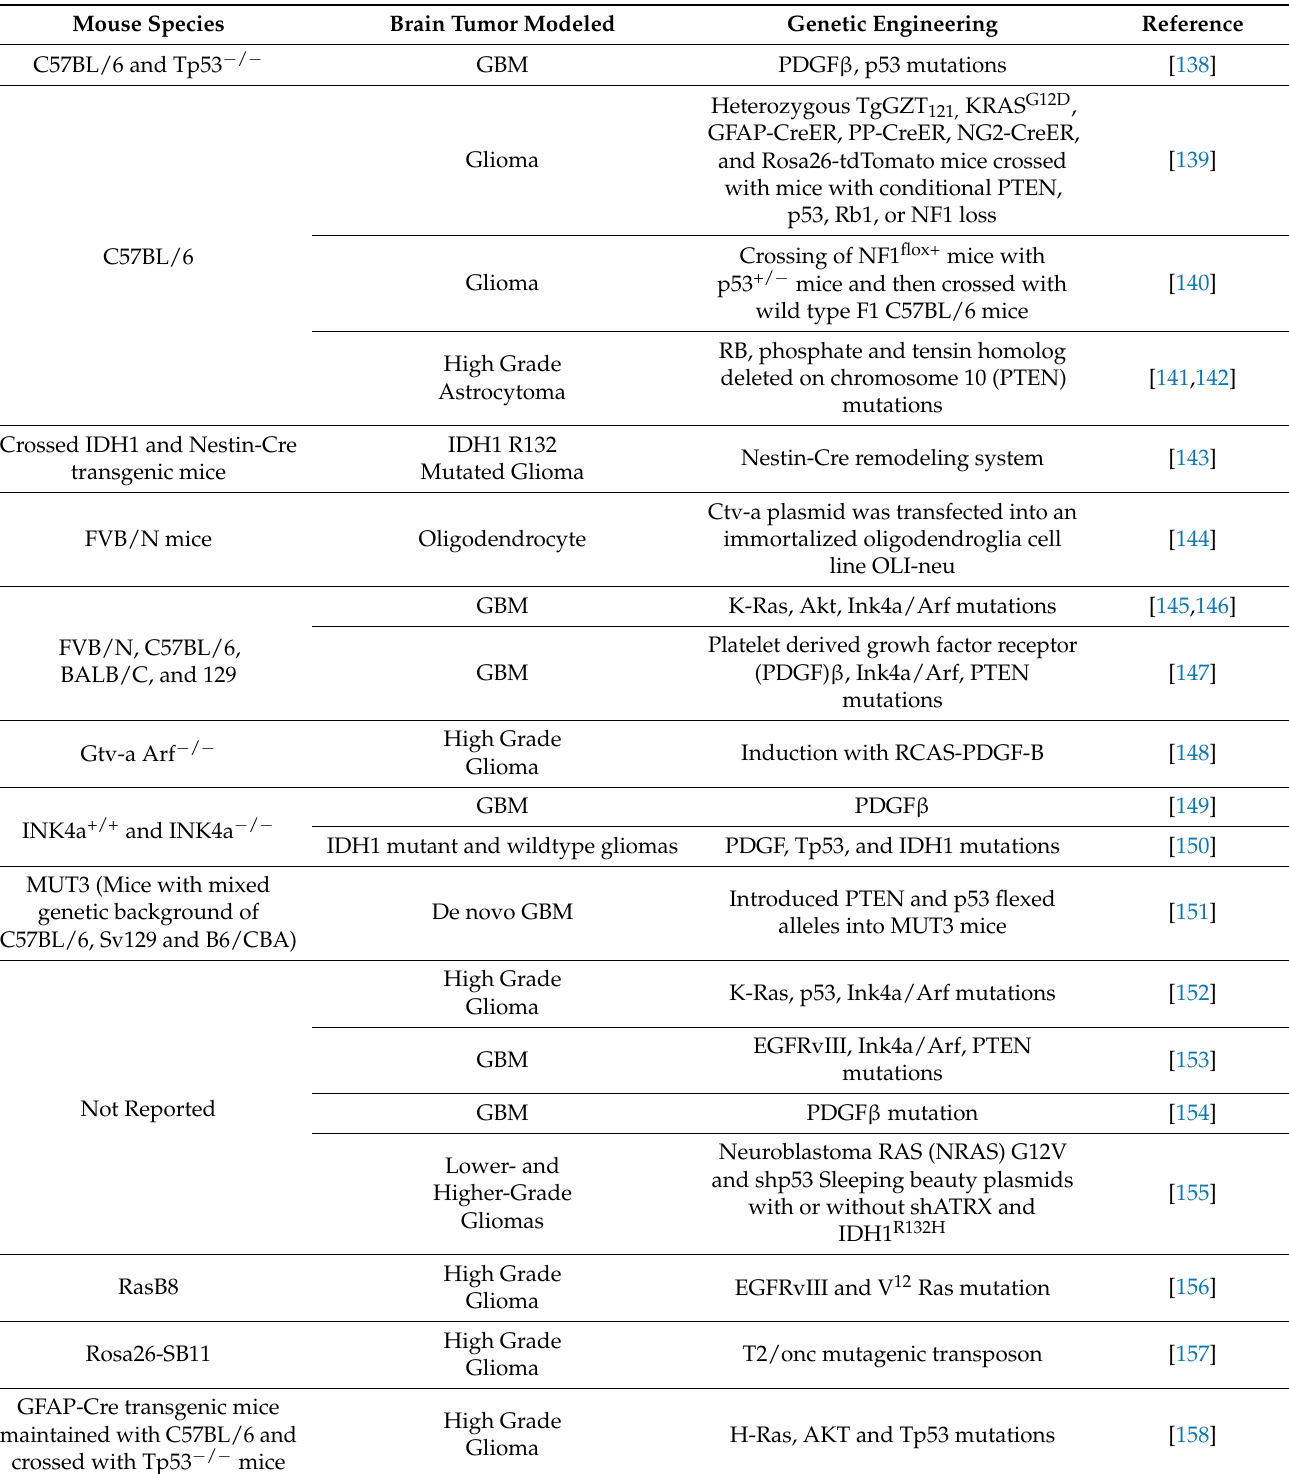
Table 4. Glioma genetically engineered mouse models